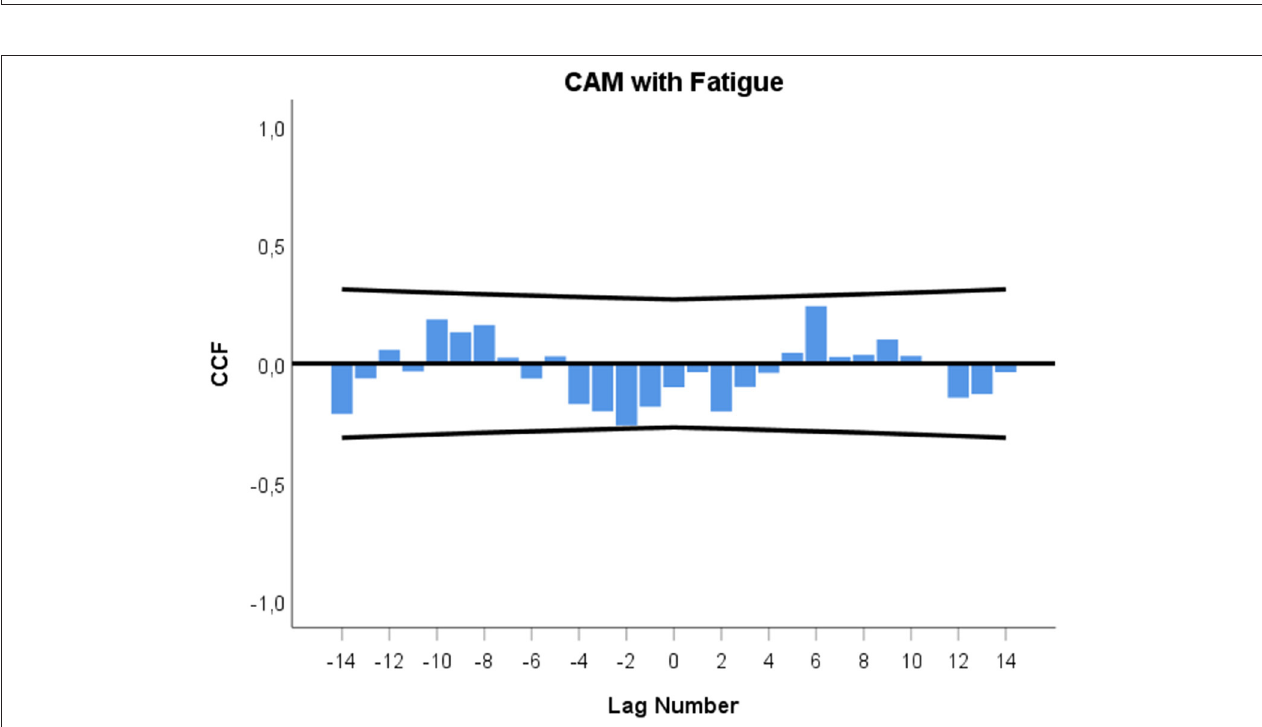
FIGURE 4 | Cross-correlation function (CCF) between CAM practice experienced as positive and fatigue. Each lag represents a time interval of 12h. Cross-correlation coefficients (bars) reaching the upper or lower limits of the 95% confidence intervals (lines) are significant at p < 0.05. Lag 0 on the x -axis signifies the time of a CAM event. A zero lag significance means that CAM is followed by a fatigue change during the next 12h. A positive lag significance means that CAM is followed by a fatigue change, whereas a negative lag significance means that a fatigue change precedes CAM.